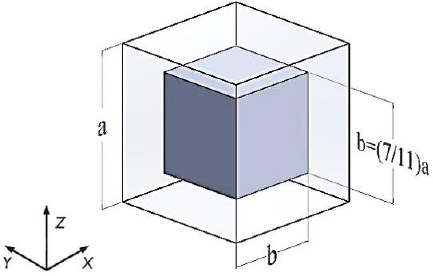
Figure 1. A 3D phononic crystal of a unit-cell cubic form, with a cube inclusion.